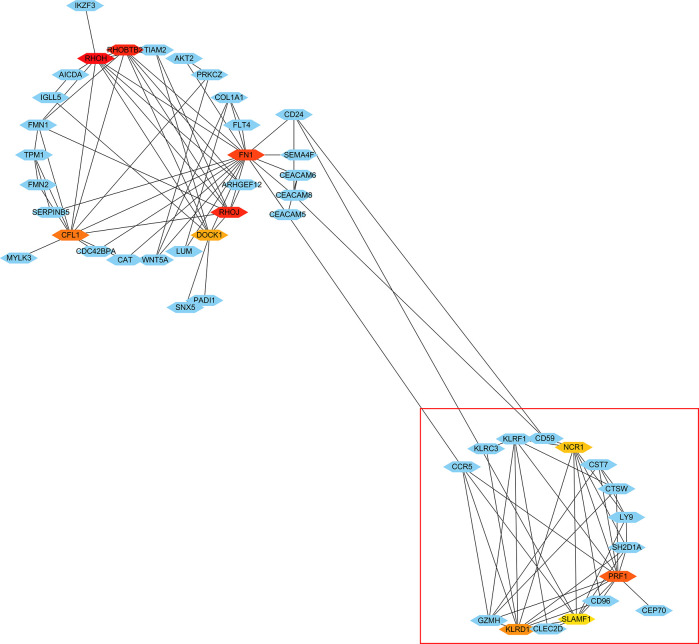
Cytoscape network clustering visualization of hub DEGs in monocytes from low-peak bone mass samples. The nodes represent genes and the edges represent links between genes. The red/orange/yellow color means the MMC scores is highest/moderate high/mild high.